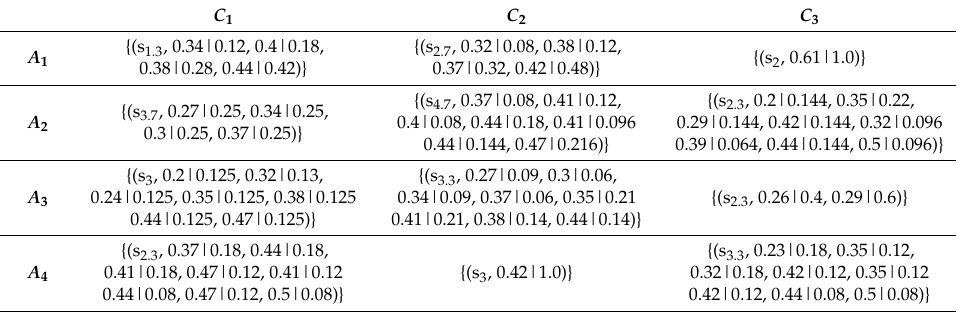
Table 4. Aggregated hesitant probabilistic fuzzy linguistic element (HPFLE) group decision matrix using hesitant probabilistic fuzzy linguistic weighted averaging (HPFLWA) operator.